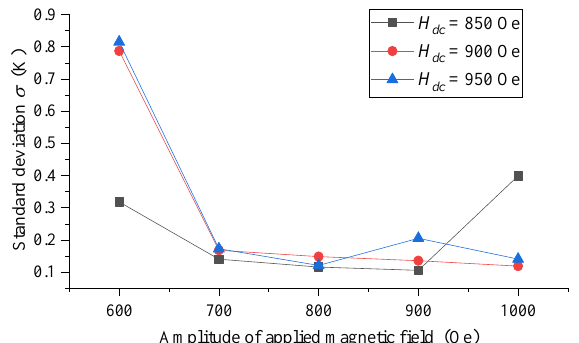
Figure 10. The standard deviation of 5 nm MNPs with the changing amplitude of triangular wave excitation magnetic field in different DC bias magnetic field H dc .